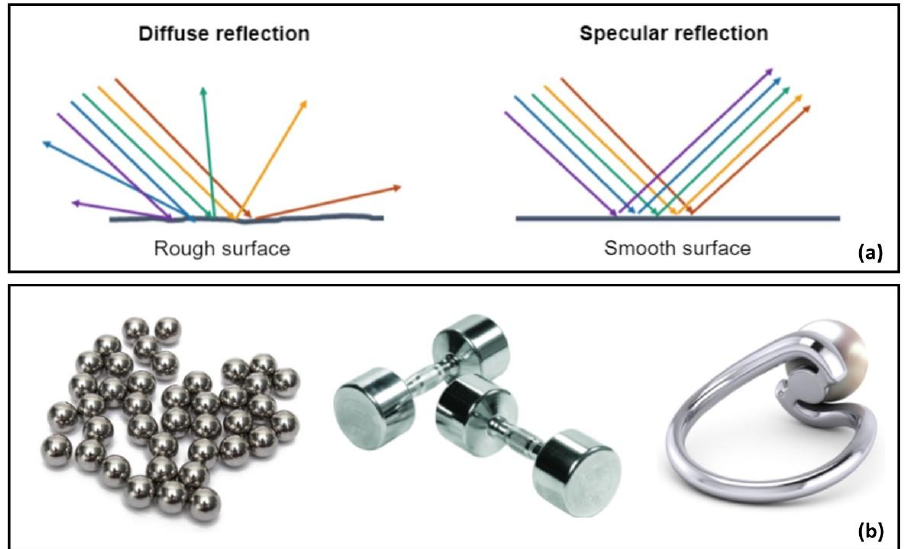
Figure 1. ( a ) The difference between specular and diffuse reflections. ( b ) Some examples for specular reflections on metallic objects.